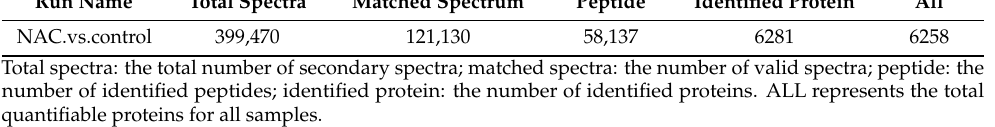
Table 1. Total numbers of identified peptides and proteins. Run Name Total Spectra Matched Spectrum Peptide Identified